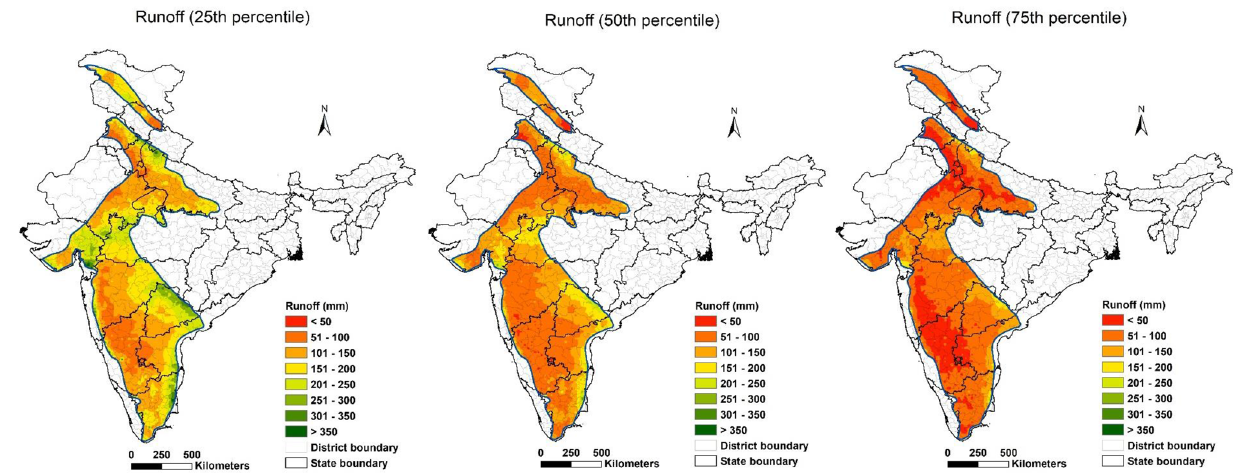
Figure 14. Runoff probabilities in the semi-arid tropics of the Indian